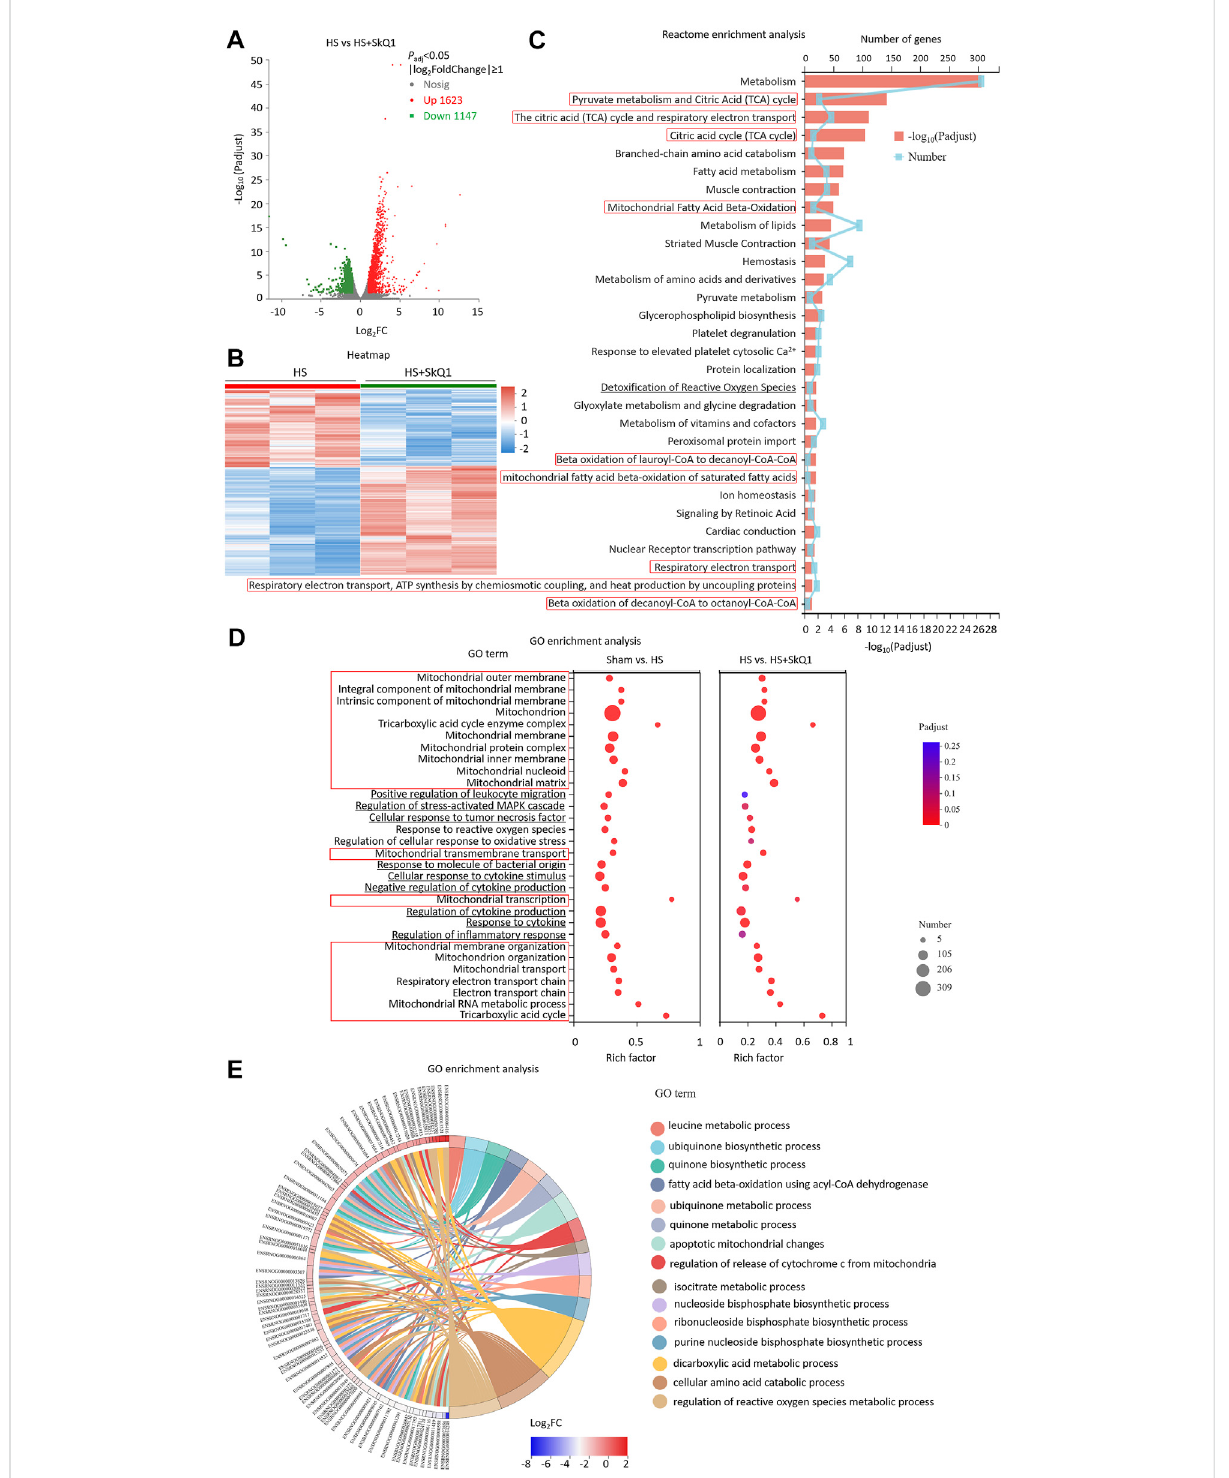
FIGURE 5 SkQ1 treatment after HS causes DEGs of myocardial tissues enriched in the mitochondrial and ROS-related pathways. (A) The volcano plot showing number of differentially expressed genes (DEGs) of HS + SkQ1 and HS rat heart tissues; P adj < 0.05, n = 3 rats per group. (B) A heat map summary of the DEGs expression values of HS + SkQ1 and HS group. Red indicates high and green indicates low gene expression P adj < 0.05, n = 3 mice per group. (C) Reactome enrichment analysis and (D) GO enrichment analysis of all the DEGs and GO cluster plot showing a chord dendrogram (E) of the clustering of the expression spectrum of the 278 DEGs in the mitochondrion GO term between HS + SkQ1 and